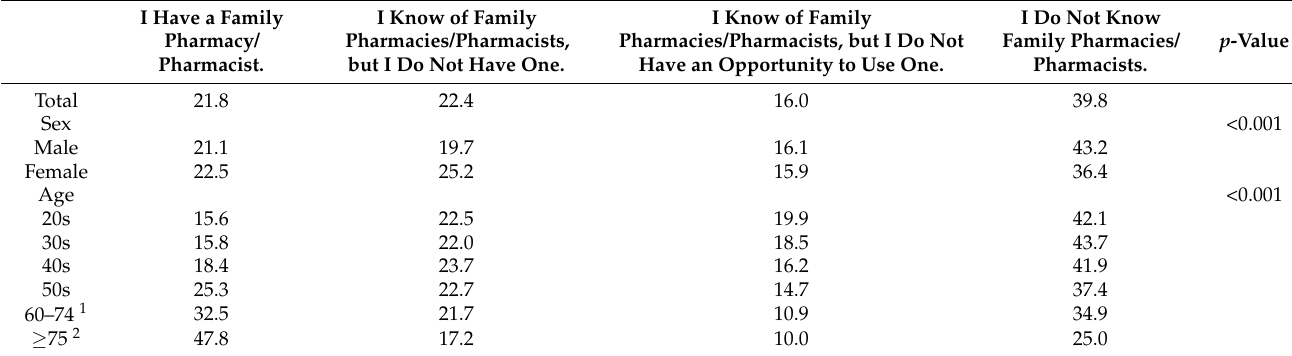
Table 1. Recognition of family